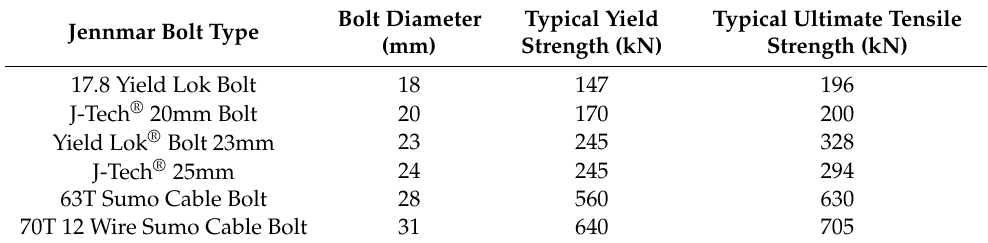
Table 2. Jennmar bolt properties.